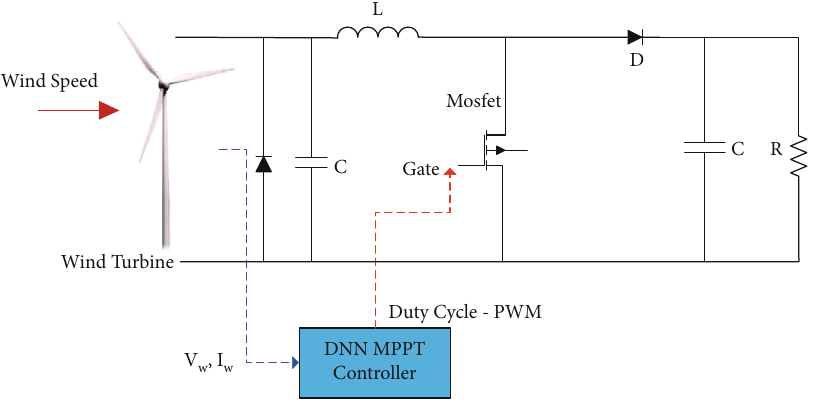
Figure 11: Proposed DNN-based MPPT algorithm (wind energy